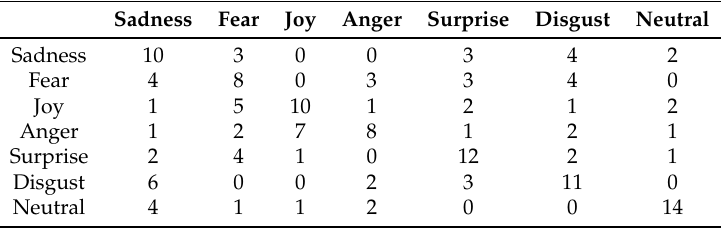
Table A7. P7 actor confusion matrix from the RekEmozio dataset in the second phase.